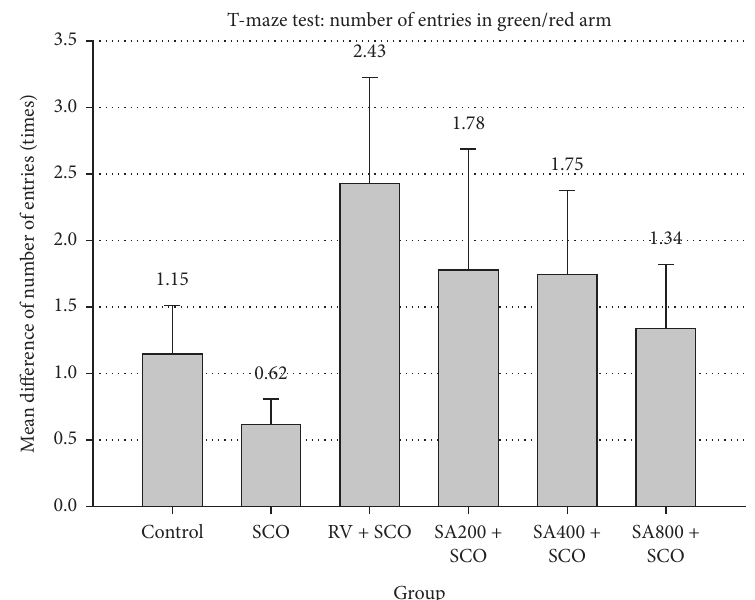
Figure 3: Effect of SCO, RV, and SA extract on number of entries in the colour-biased appetite conditioning T-maze test. Mean difference of total number of entries into green arm and red arm expressed as mean ± SEM. Zebrafish that received RV +SCO, SA200+SCO, SA400+SCO, and SA800+SCO showed mean difference of total number of entries at more than 1 as 2.43 ± 0.80, 1.78 ± 0.91, 1.75 ± 0.63, and 1.34 ± 0.48,